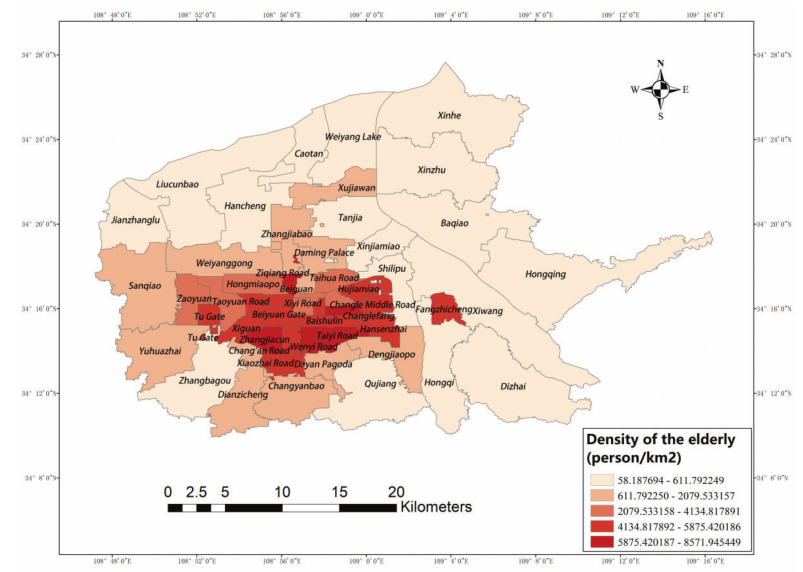
Figure 3. Population density.